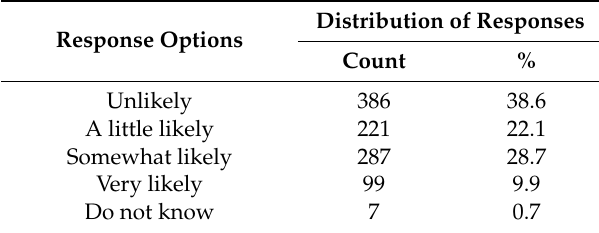
Table 4. The distribution of responses to the question: ‘How likely are you to make an e ff ort to eat less than you want?’ ( n =